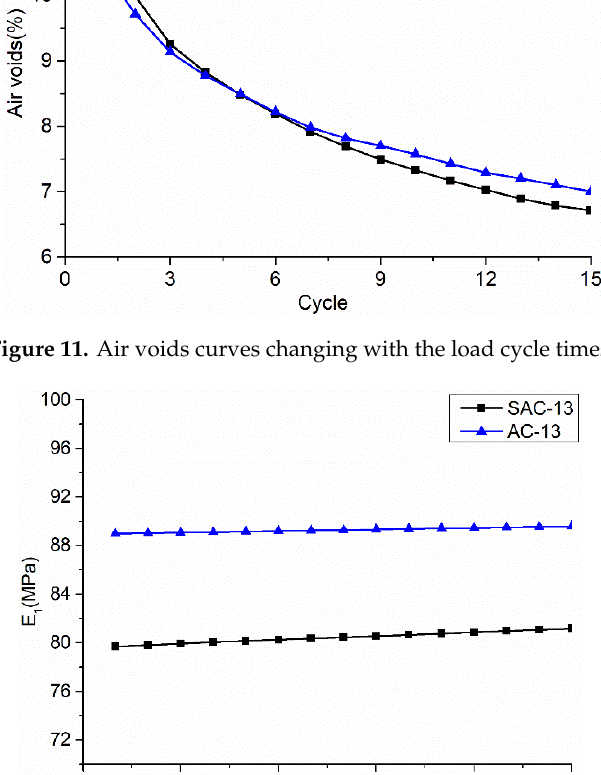
Figure 12. Elastic parameters curves changing with the load cycle times.